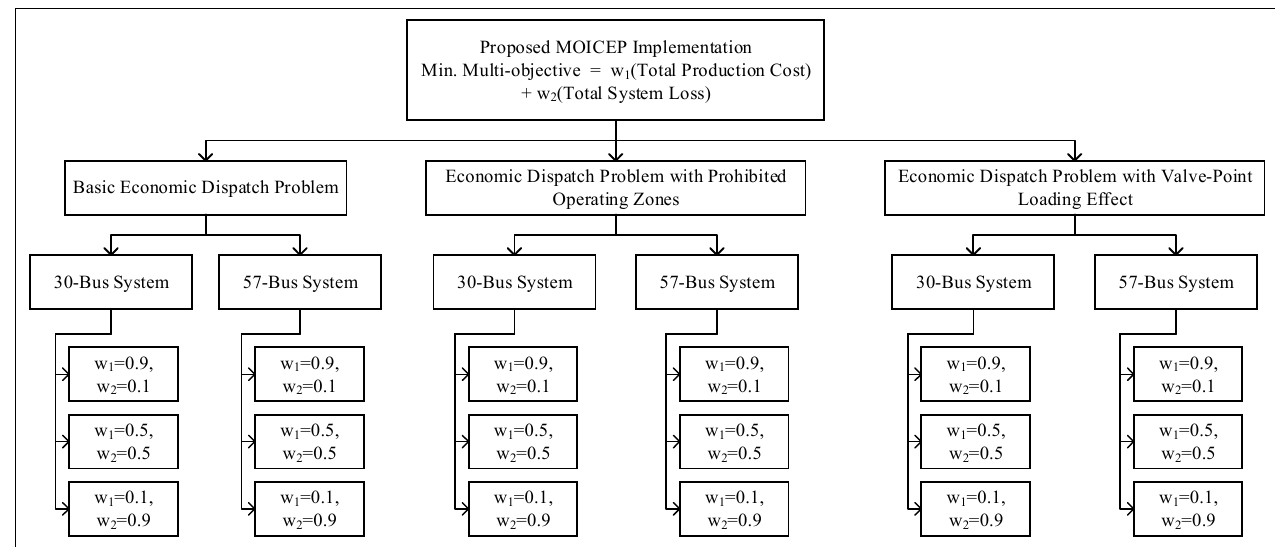
Figure 2. Overall implementation of the MOICEP for total production cost and total system loss minimization.